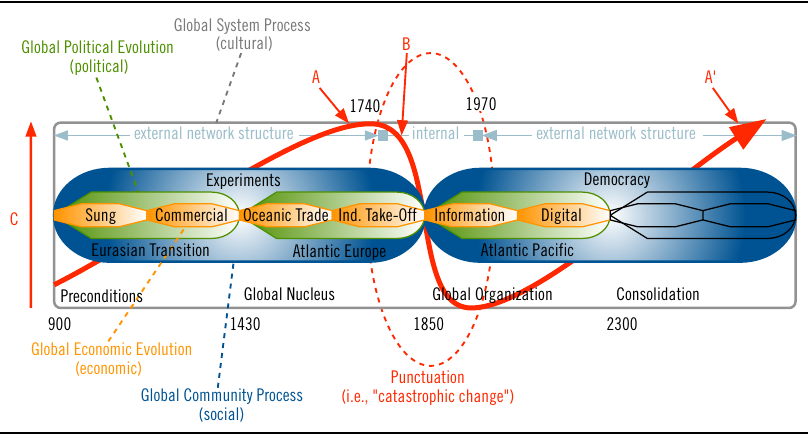
Figure 1 – Evolutionary Model of Global System Formation, 930CE–2300CE*